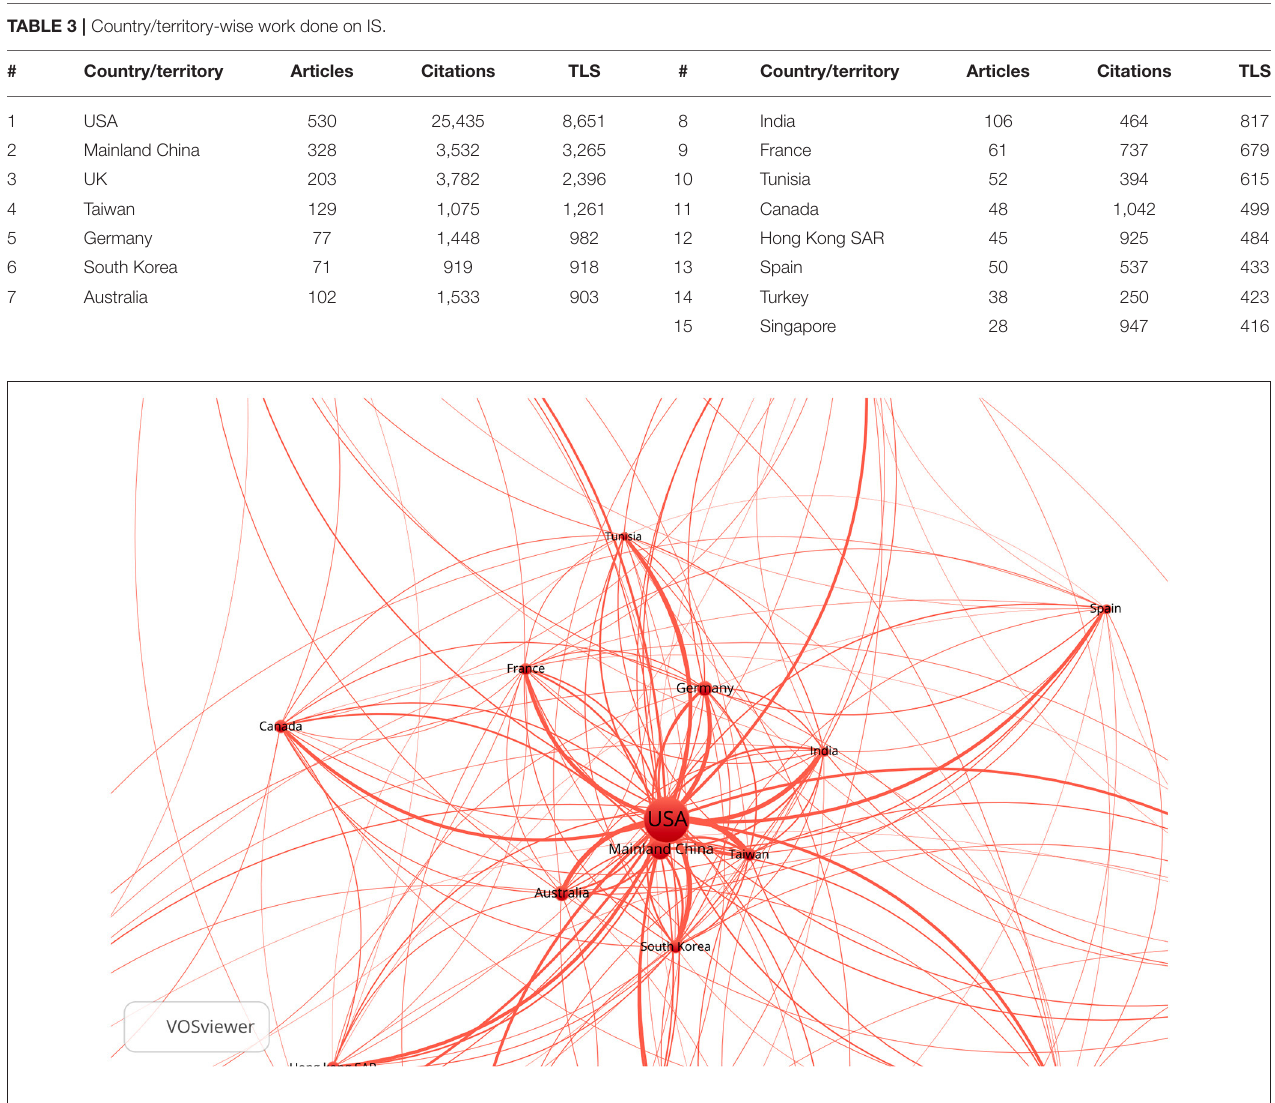
FIGURE 1 | Country/territory-wise work done on IS. which are relatively described as inefficient markets. The stock market’s inefficiency indicates institutional investors’ lack of systematic arbitrage opportunities, providing a platform to assess